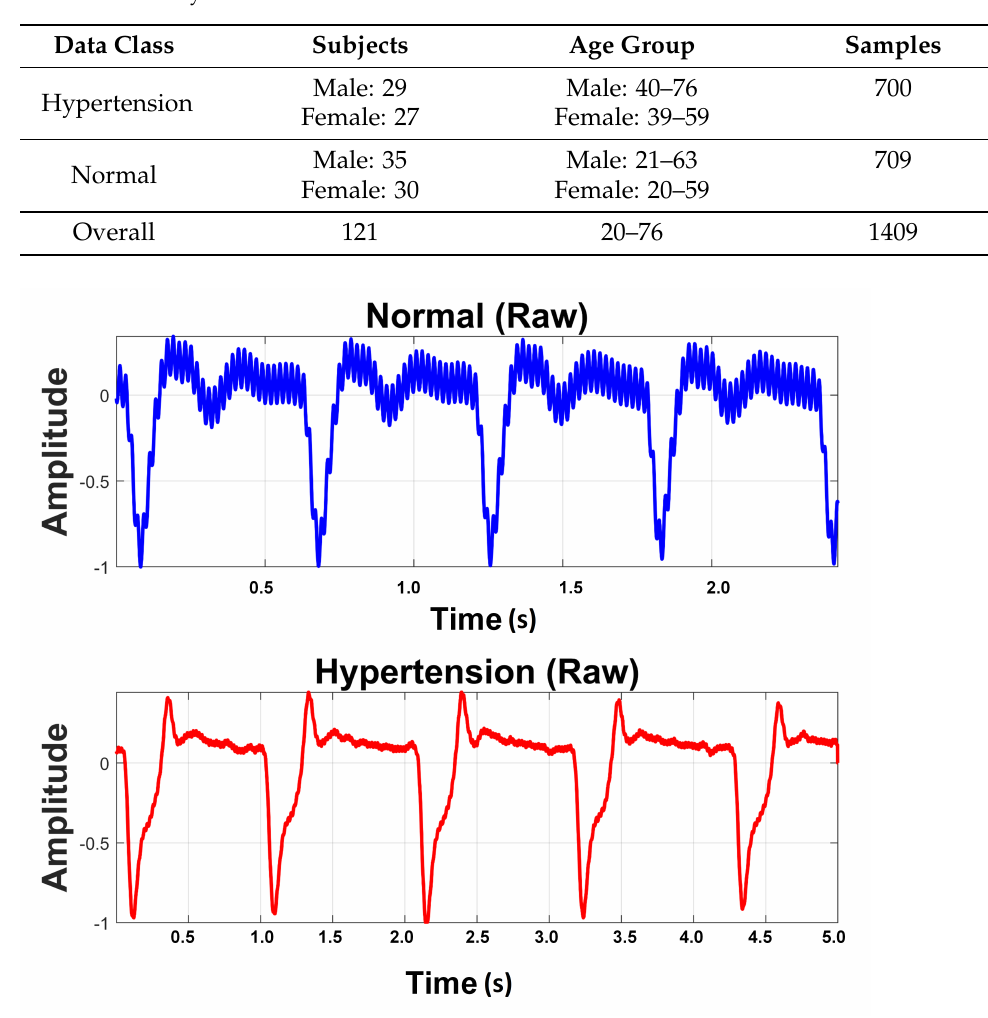
Figure 2. Raw PuPG signals of Normal and Hypertension